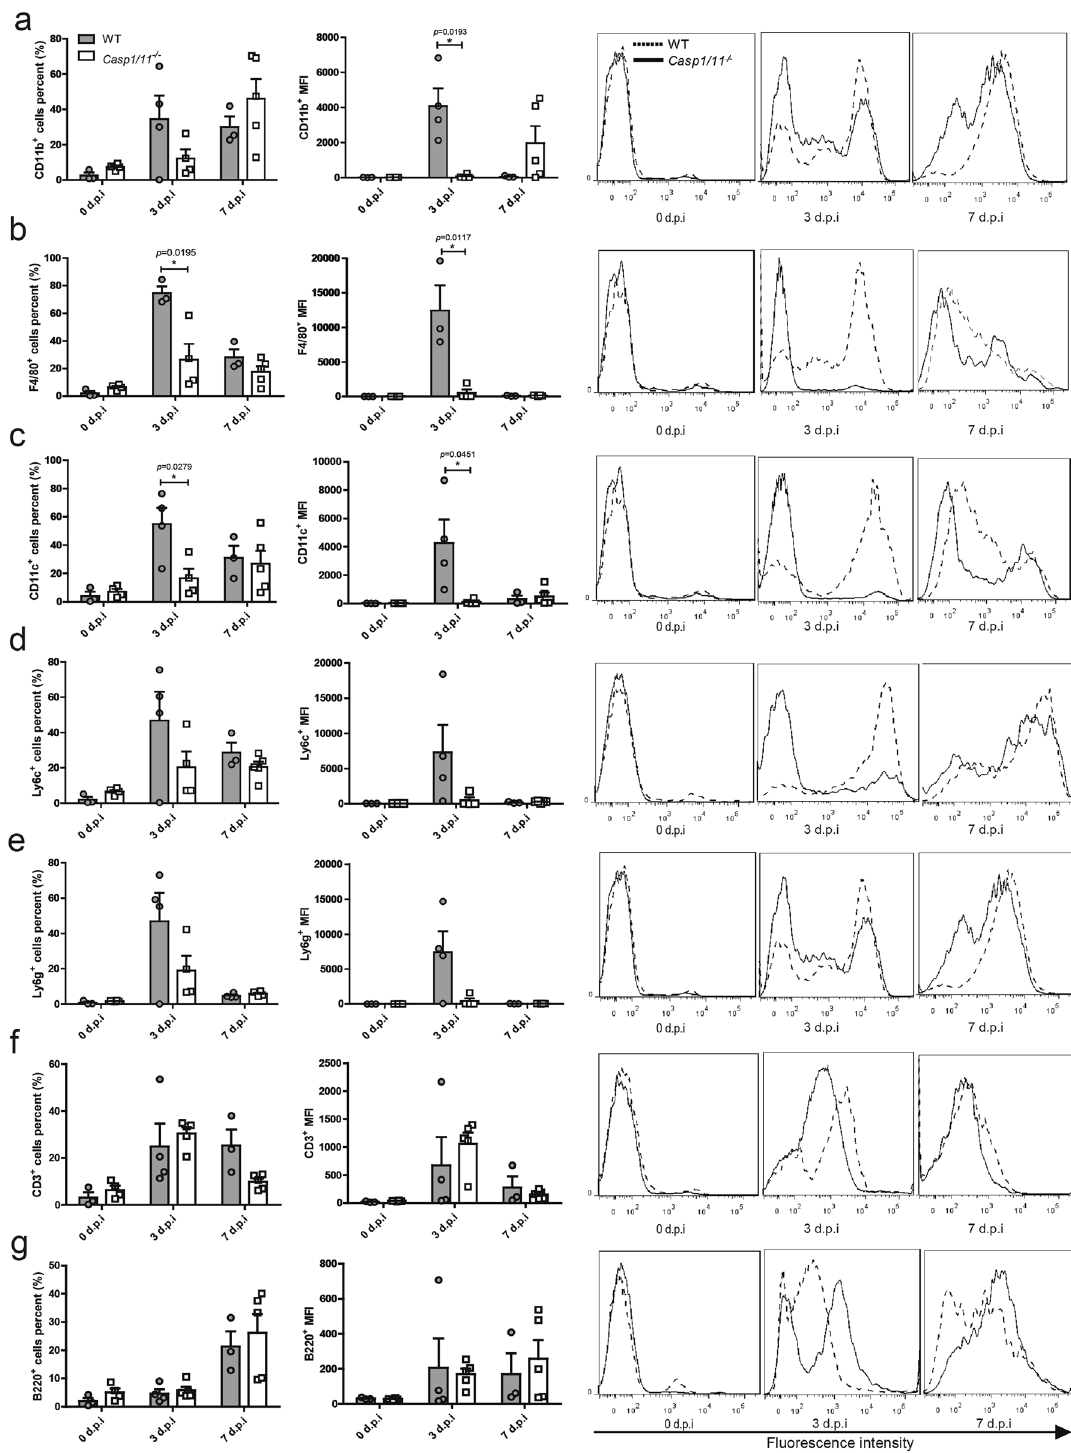
Figure 4. Deficiency of caspase-1 reduces the proinflammatory leukocytes recruitment to the lungs during H7N9 infection. WT and Casp1/11 − / − mice were infected as described in the legend for Fig. 2. The BALFs were collected at the indicated time points and leukocytes were stained with specific antibodies before flow cytometric analysis (FACS). Graphs on the left panel represent the mean values from 3–5 mice per group and are expressed as the mean ± SD. * P < 0.05. Histograms on the right panel show representative FACS data. The solid line denotes the Casp1/11 − / − mice, and the dashed line denotes the WT mice. Data are pooled from three independent infection experiments. * P <